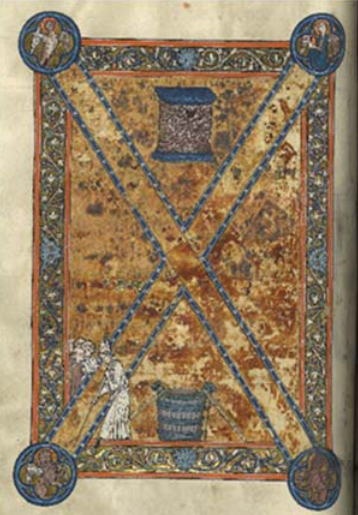
Figure 1. Bishop writing ACT.59 ‐ 60 fº100v. © Toledo Cathedral Archive.